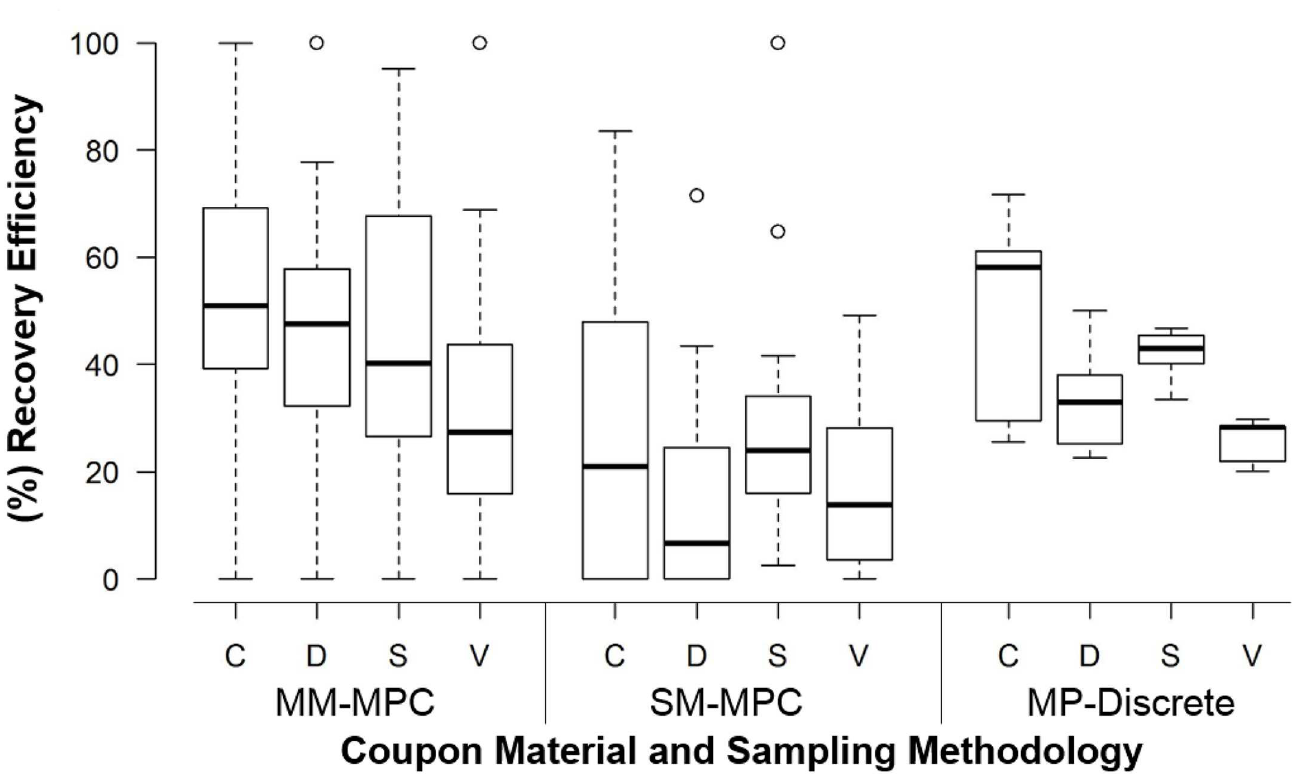
Fig 4. Coupon material and compositing methodology are significant experimental factors on the response variable, recovery efficiency. Of the materials tested, ceramic tile and stainless steel had the highest recovery efficiency and vinyl tile had the lowest RE. For all materials and CFU targets tested (10, 25, 50, 100 CFU), the MM-MPC method yielded higher RE than the SM-MPC method. The process controls, MP-Discrete, data are includedfor comparative purposes. C = ceramic; D = drywall; S = stainless steel; V = vinyl